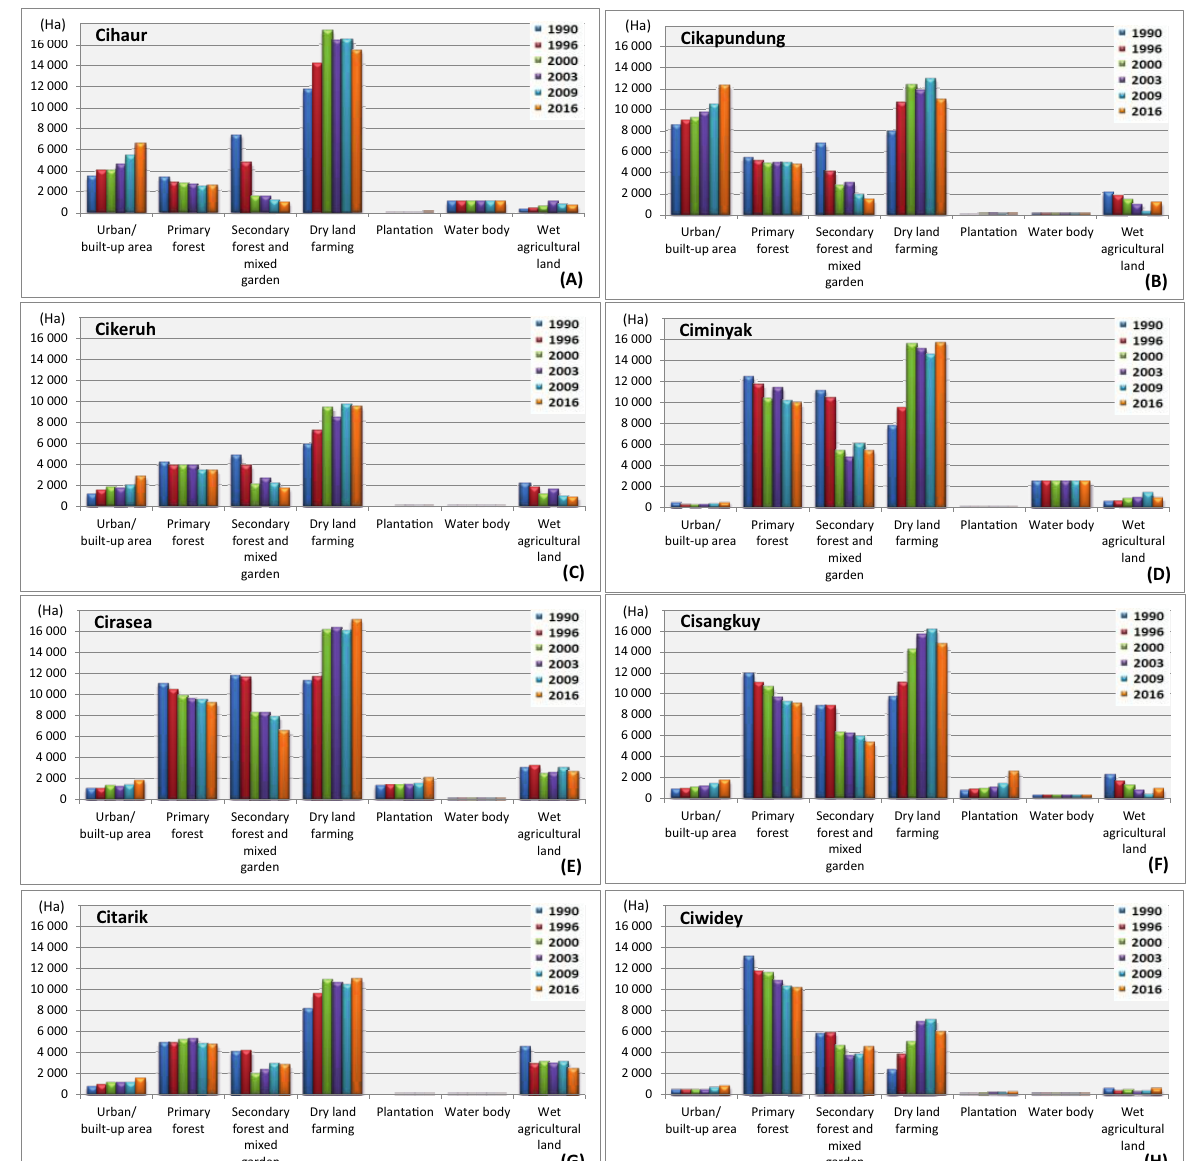
Fig. 5. The dynamics of LULC changes during 1990–2016 in the eight sub-watersheds in the study